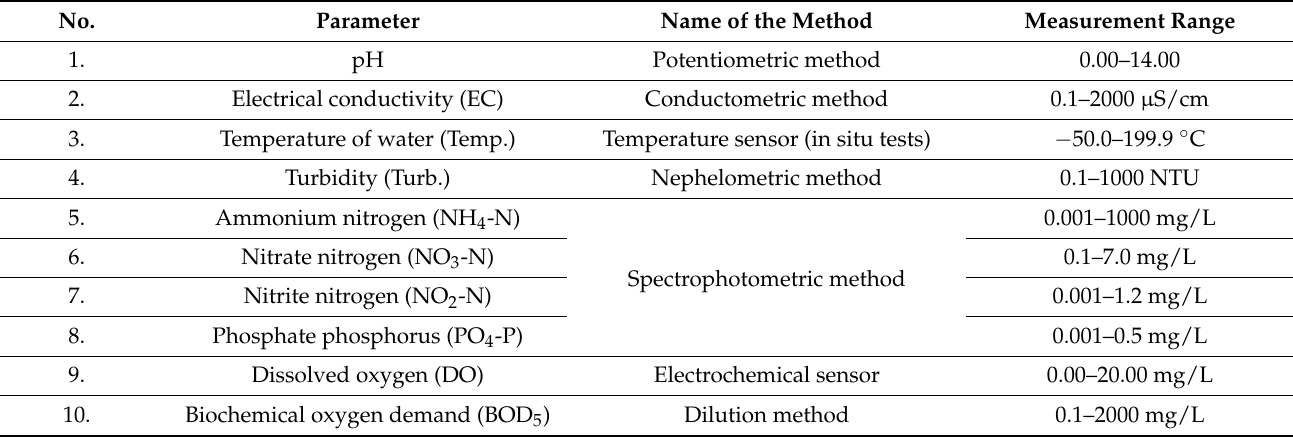
Table 1. Specification of laboratory methods for physicochemical determinations of water